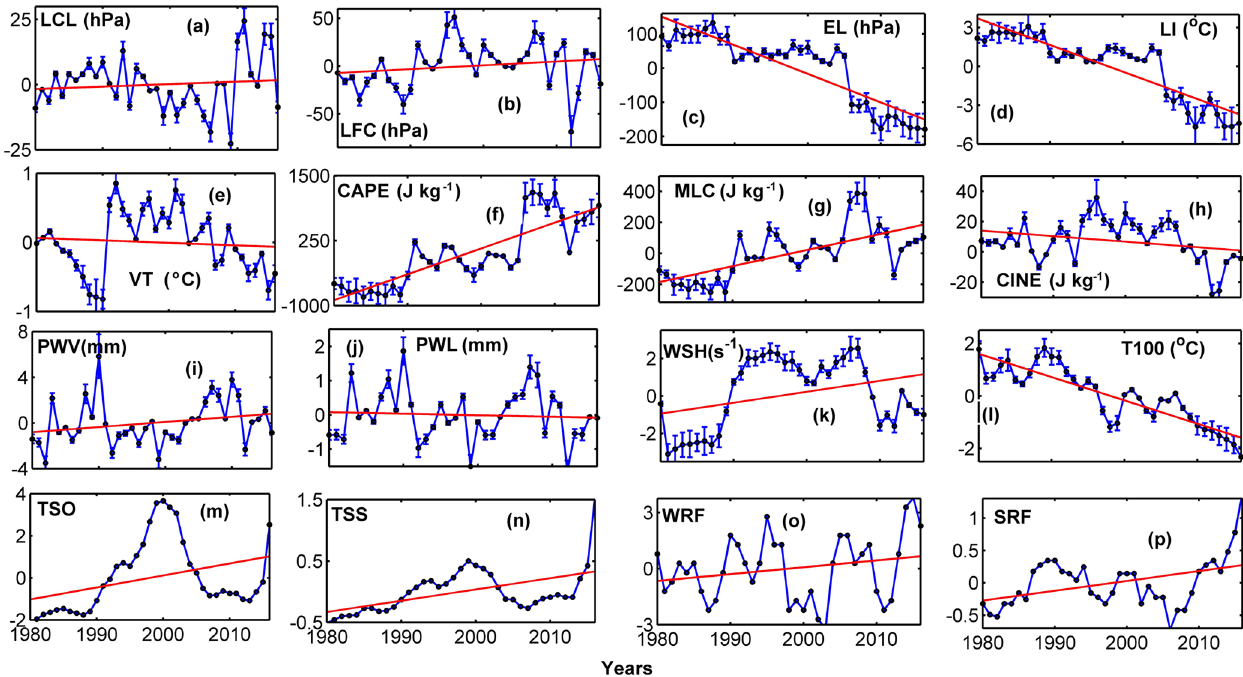
Figure 3. Long-term variation of (a) LCL, (b) LFC, (c) EL, (d) LI, (e) VT, (f) CAPE, (g) MLC, (h) CINE, (i) PWV, (j) PWL, (k) WSH, (l) T 100, (m) TSO, (n) TSS, (o) WRF, and (p) SRF observed over